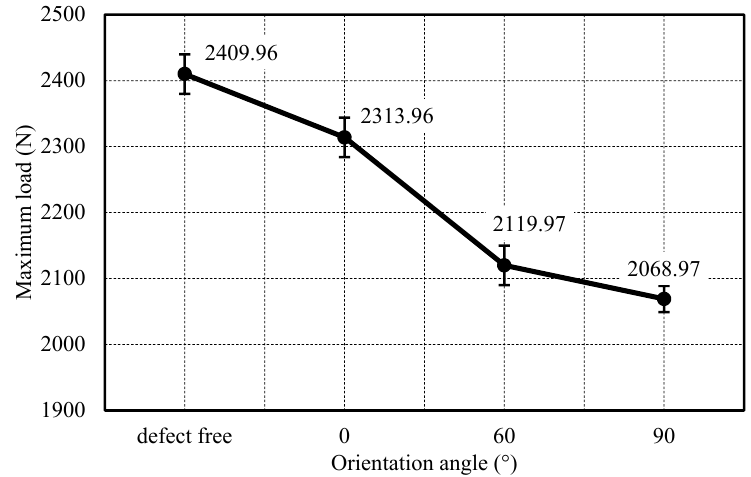
Figure 11. Effect of the defect orientation on the peak load. Figure 11. E ff ect of the defect orientation on the peak load.